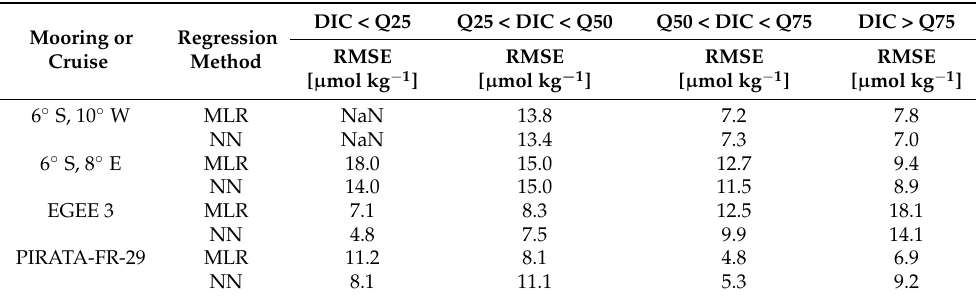
Table A3. RMSE for each DIC interval for both MLR and NN methods tested on the two time-series stations and the two